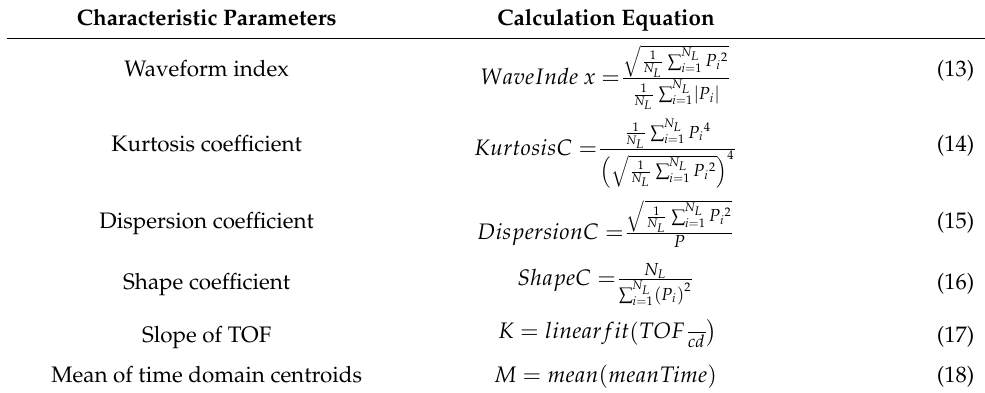
Table 2. “Line” characteristic parameters of UGW